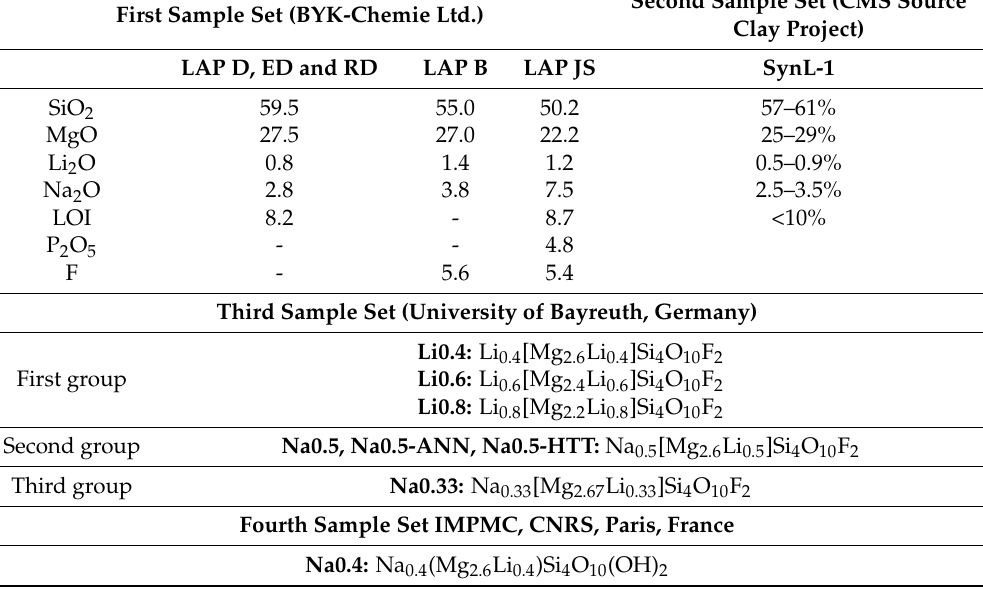
Table 1. Sample abbreviations, chemical compositions (wt %) and/or target structural formulae of the synthetic hectorites/laponites. LAP indicates laponite. First Sample Set (BYK-Chemie